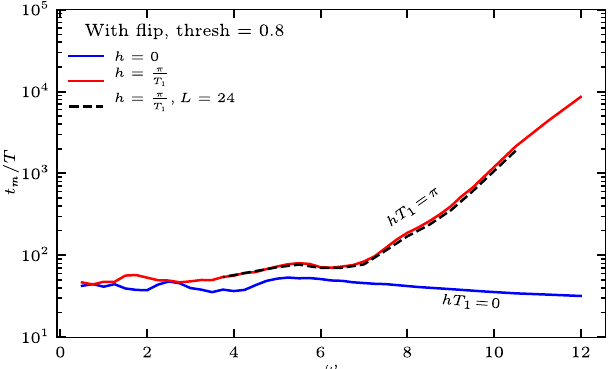
FIG. 2. Number of driving periods needed to reach a magneti- 0 . 8 , which serves as an estimate for t zation threshold of C m tot ¼ for the data in Fig. 1 with no ( h ¼ 0 ) and maximal field ( h ¼ π =T 1 ). At large frequencies, the maximal field data shows a greatly increased t m with an exponential dependence on ω . The dashed curves show additional data for longer chains ( L ¼ 24